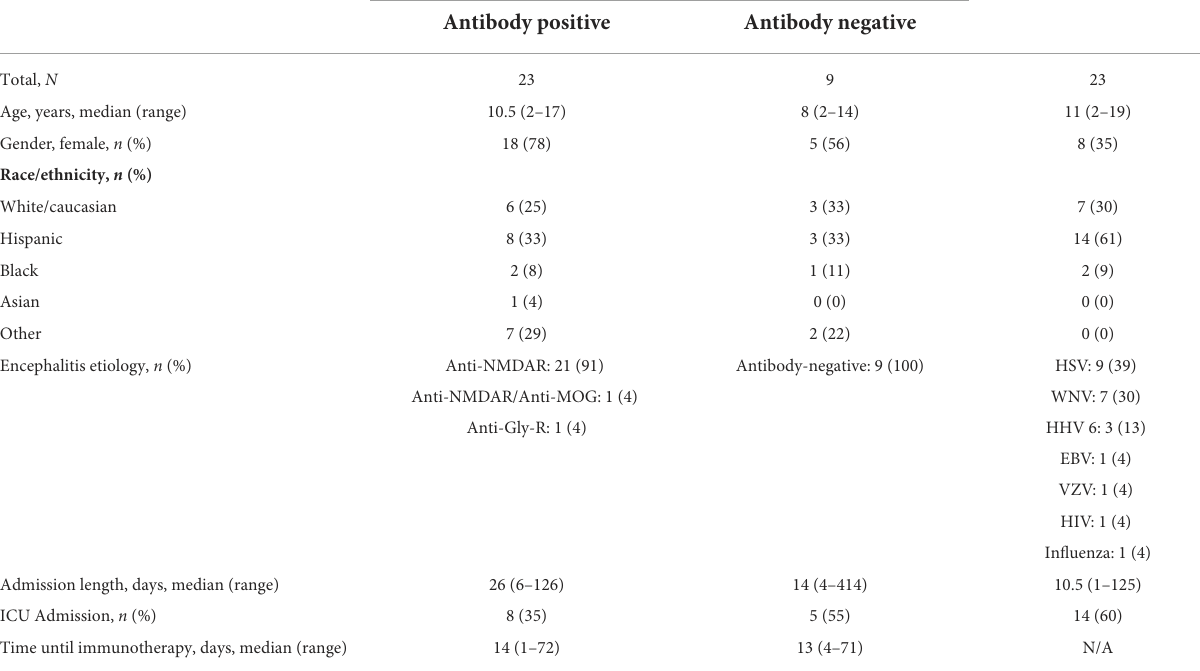
TABLE 1 Demographics and descriptive statistics of patients included in study. Autoimmune encephalitis Infectious encephalitis Antibody